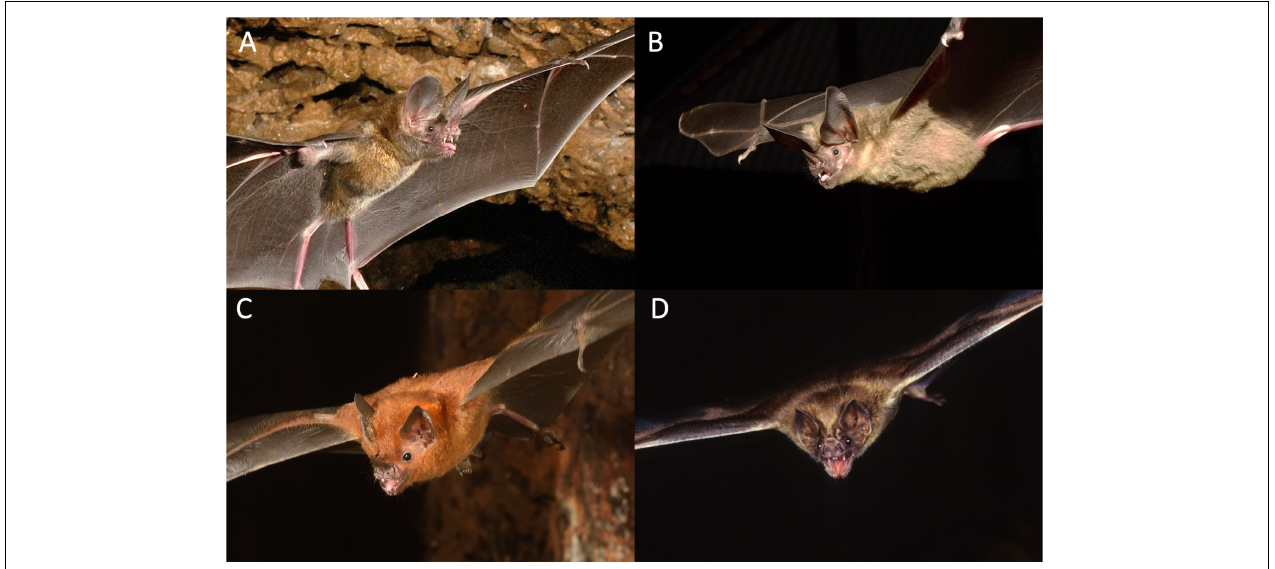
FIGURE 1 | Phyllostomid bats photographed in flight with open mouths. (A) Trachops cirrhosus , (B) Lophostoma silvicolum , (C) Carollia perspicillata , (D) Desmodus rotundus (Photos by